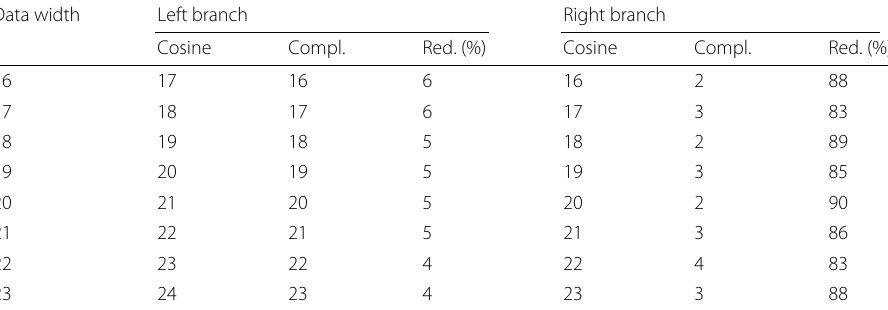
Table 2 Multiplicand width comparison of generators with a tree structure of height 1 Data